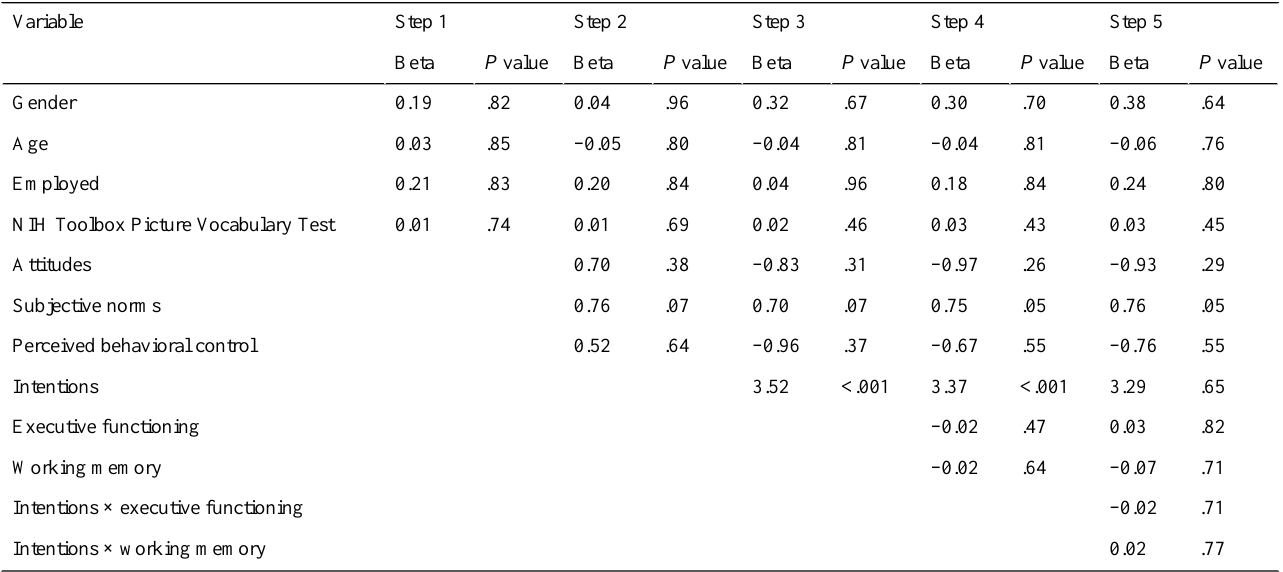
Table 4. Hierarchical regression analyses: Theory of Planned Behavior constructs and executive function as predictors of number of days using a mindfulness meditation phone app (N=85).